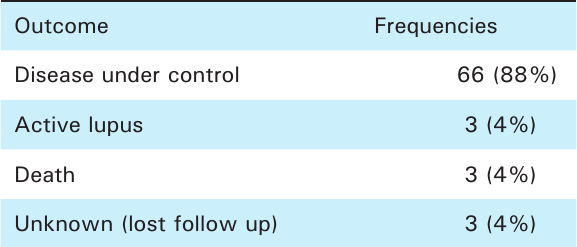
Table 2. Outcome of SLE